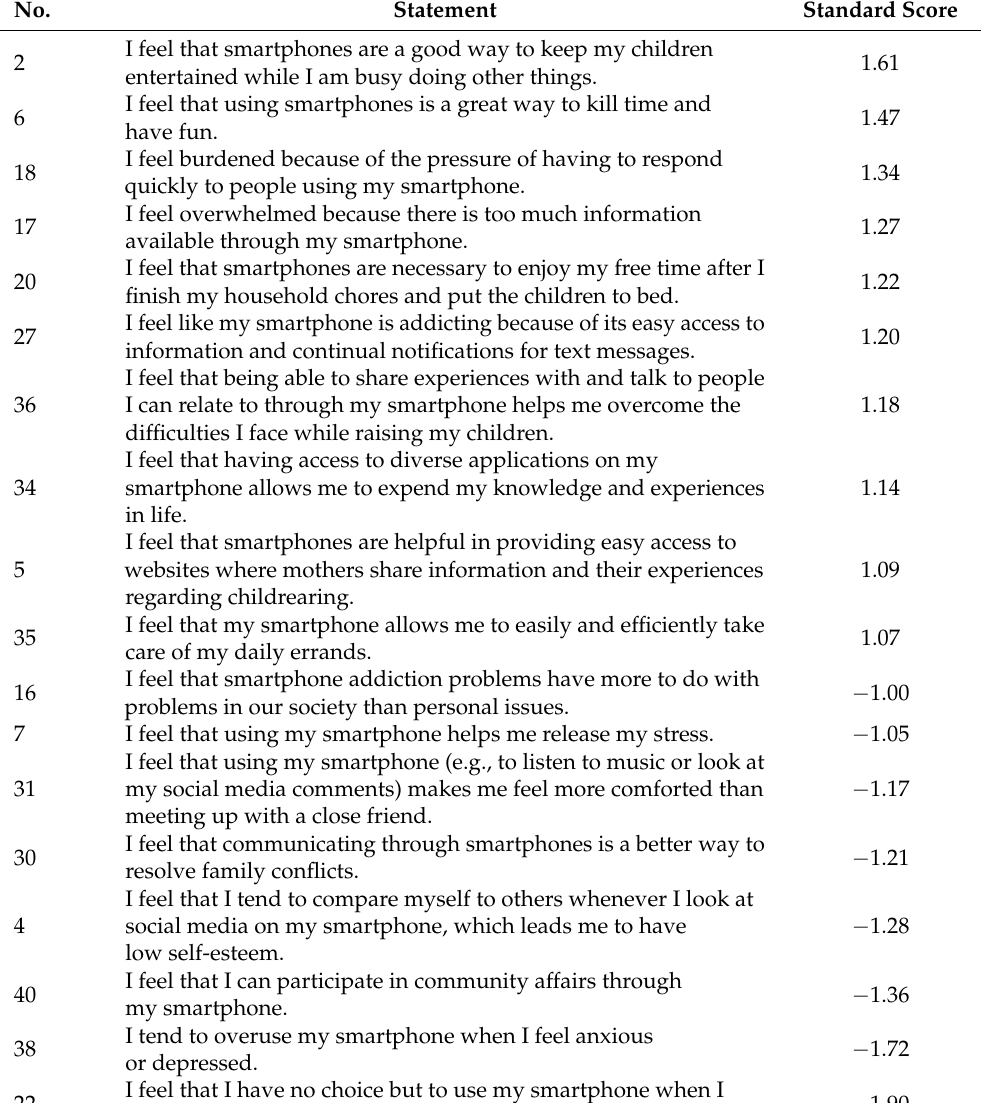
Table 6. Statements and standard scores for Type 4 ( ≥±